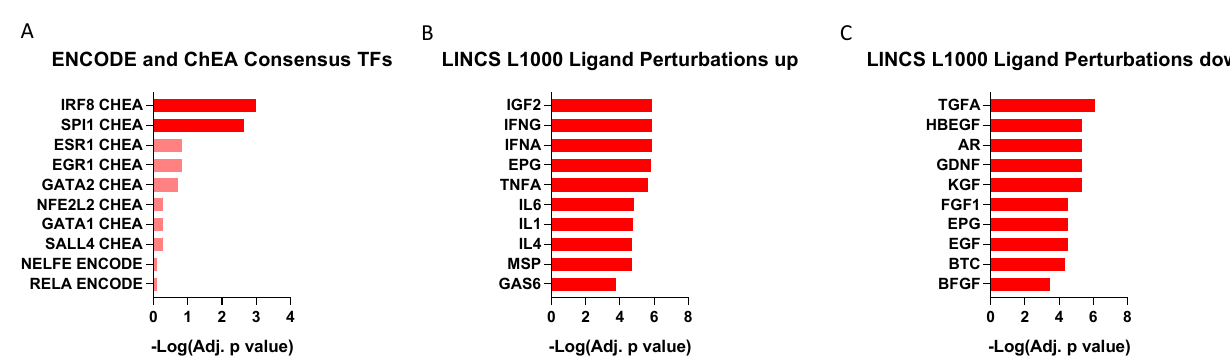
Figure 7. Regulation of Module 7 genes. ( A ) Putative transcription factors involved in the regulation of the expression of the genes belonging to Module 7, ( B ) ligand perturbation analysis showing the factor able to upregulate the expression of the genes belonging to Module 7, ( C ) ligand perturbation analysis showing the factor able to downregulate the expression of the genes belonging to Module 7.